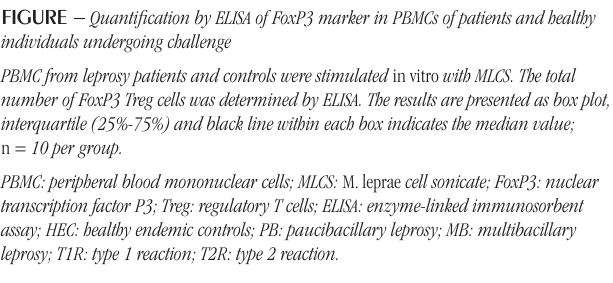
FigurE − Quantification by ELISA of FoxP3 marker in PBMCs of patients and healthy individuals undergoing challenge PBMC from leprosy patients and controls were stimulated in vitro with MLCS. The total number of FoxP3 Treg cells was determined by ELISA. The results are presented as box plot, interquartile (25%-75%) and black line within each box indicates the median value; n = 10 per group. PBMC: peripheral blood mononuclear cells; MLCS: M. leprae cell sonicate; FoxP3: nuclear transcription factor P3; Treg: regulatory T cells; ELISA: enzyme-linked immunosorbent assay; HEC: healthy endemic controls; PB: paucibacillary leprosy; MB: multibacillary leprosy; T1R: type 1 reaction; T2R: type 2 reaction.